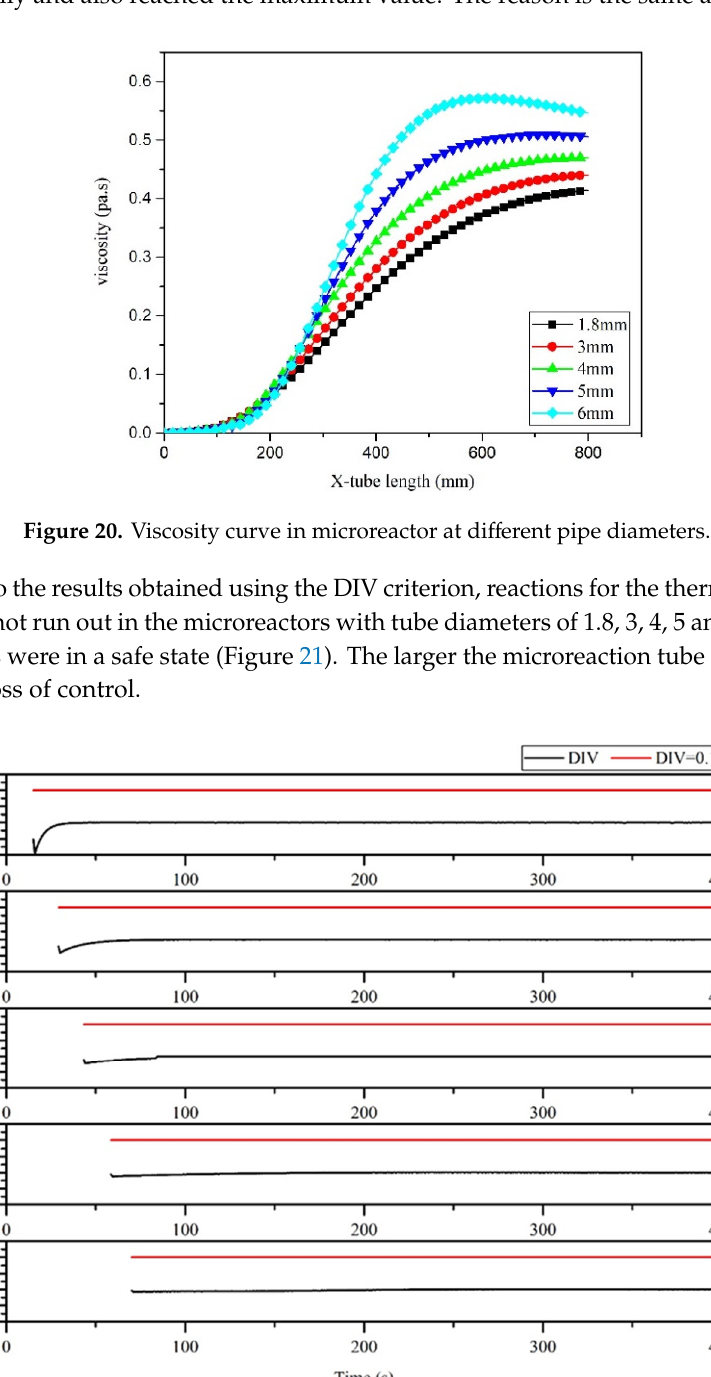
Figure 21. DIV diagram of temperature monitoring in microreactor under different pipe diameters.